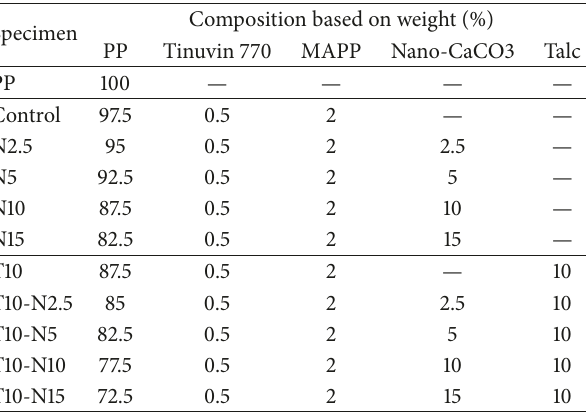
Table 1: Formulation ratios of various PP composites.